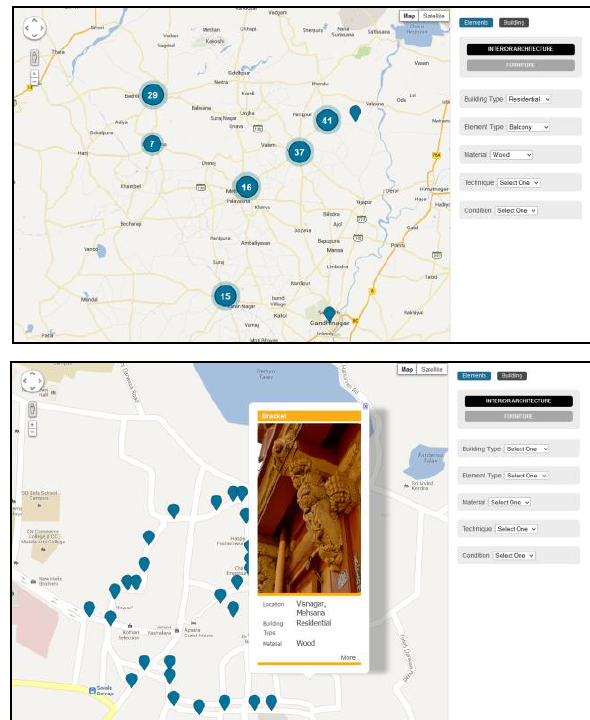
Figure 17-18. Map Application displaying mapped Interior Architecture